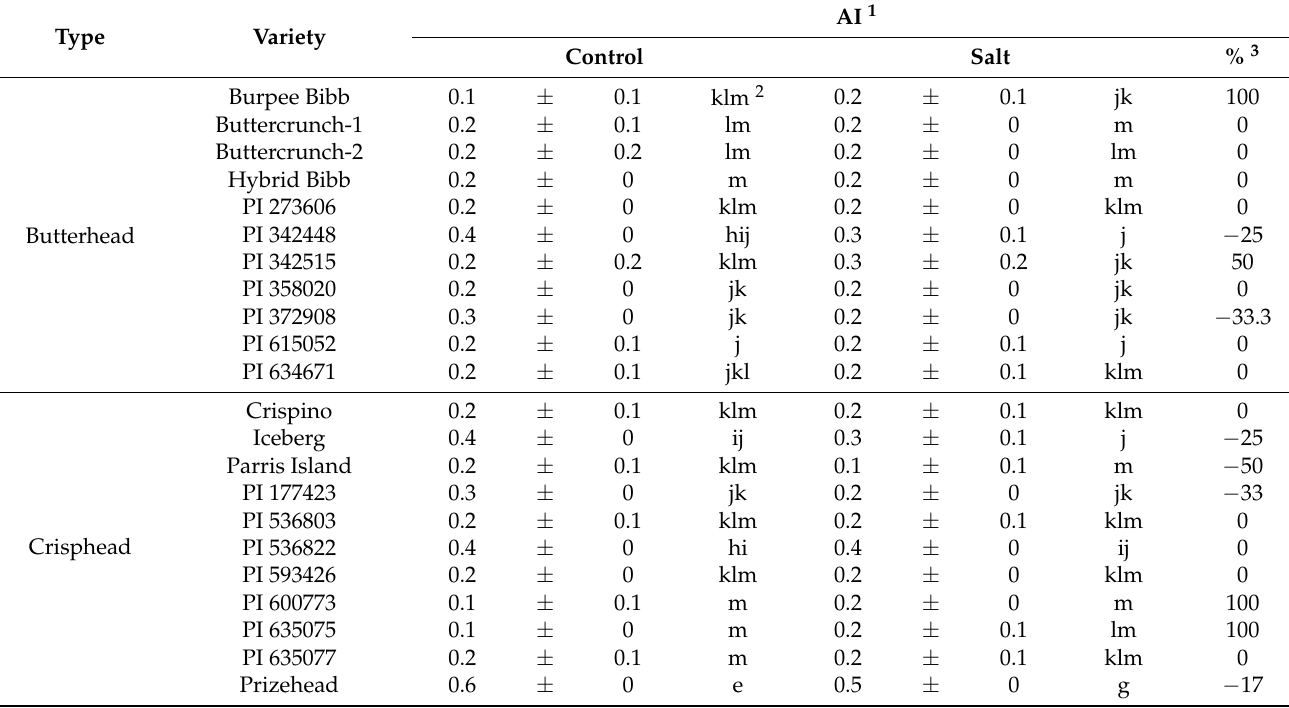
Table 13. Anthocyanin Index (AI) (mean ± standard deviation, n = 6) of butterhead- and crisphead-type lettuce cultivars grown under control and salt-stress conditions (100 mM) after 42 days of sowing (10 days after salt treatment).